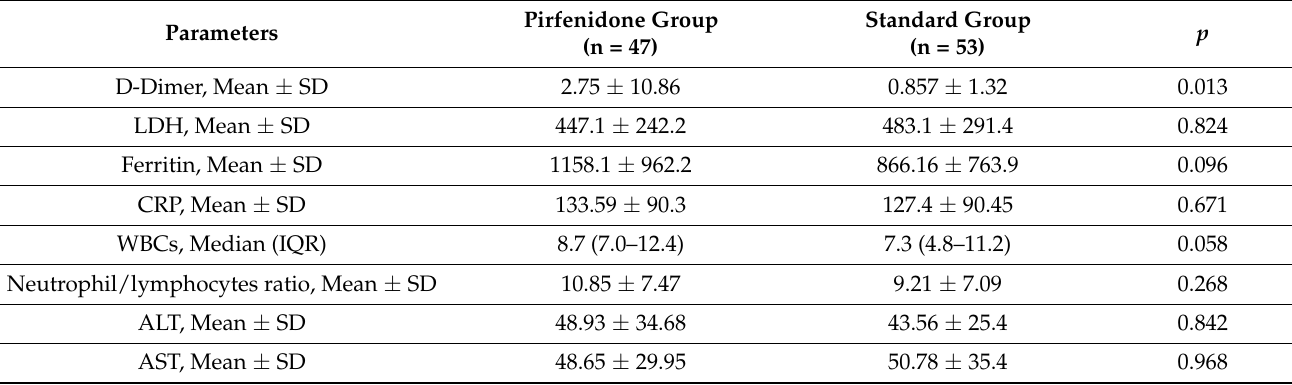
Table 2. Baseline inflammatory markers of recruited patients following cytokine storm in both